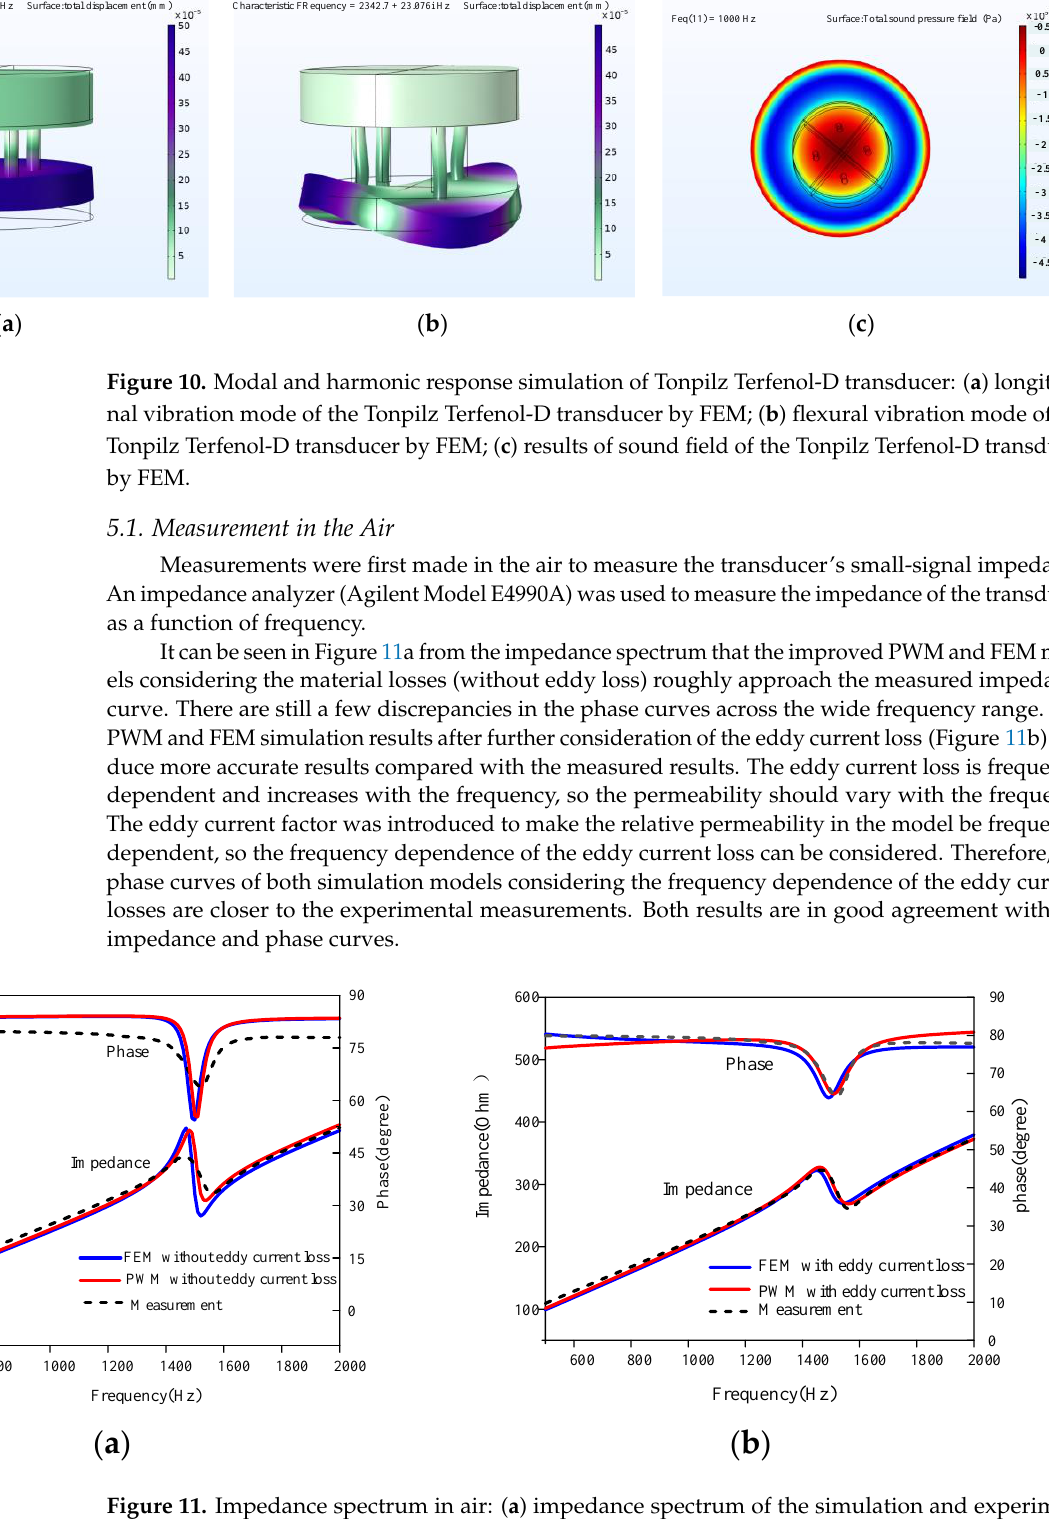
Figure 10c. The current response sent by the transducer in water can be calculated according to the far-field sound pressure value.